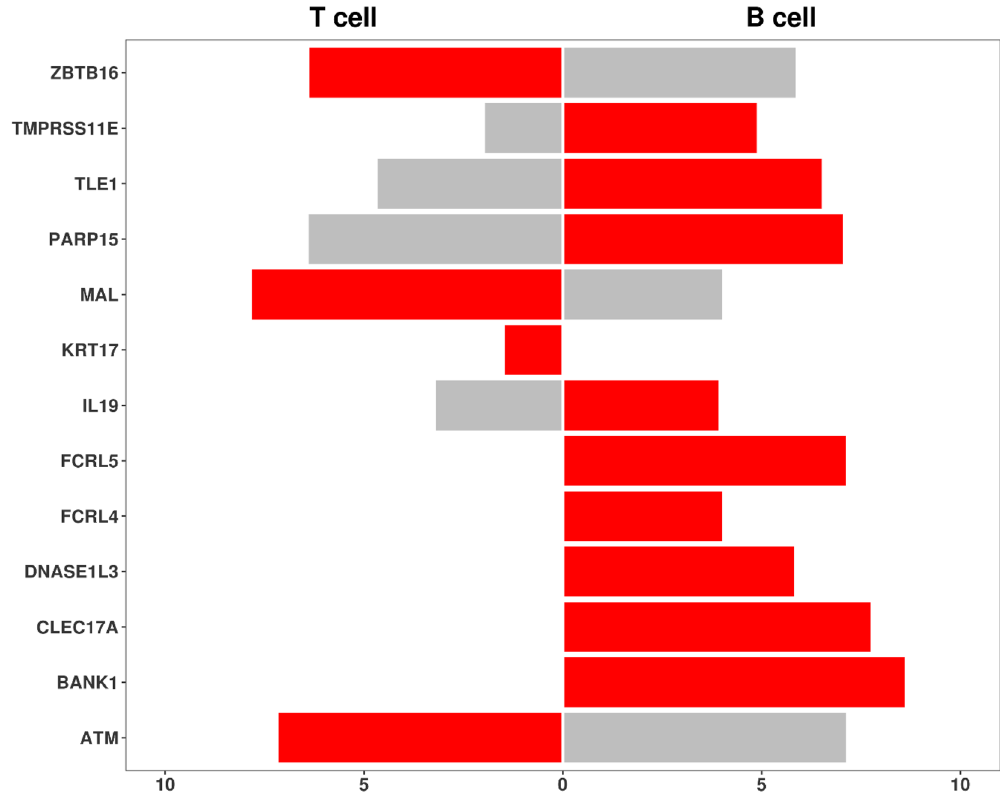
Figure 2. Gene expression in T and B cells retrieved in Human Protein Atlas database. The bars represent the mRNA expression level of each gene in T cells (on the left) or in B cells (on the right). The bar is red in the cells in which the gene is more expressed, grey